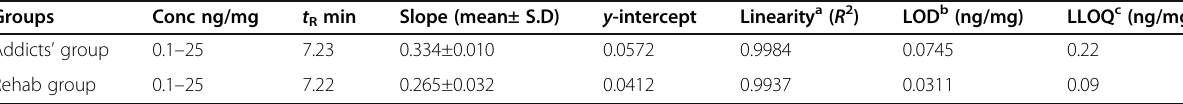
Table 1 Calibration method for sample Groups